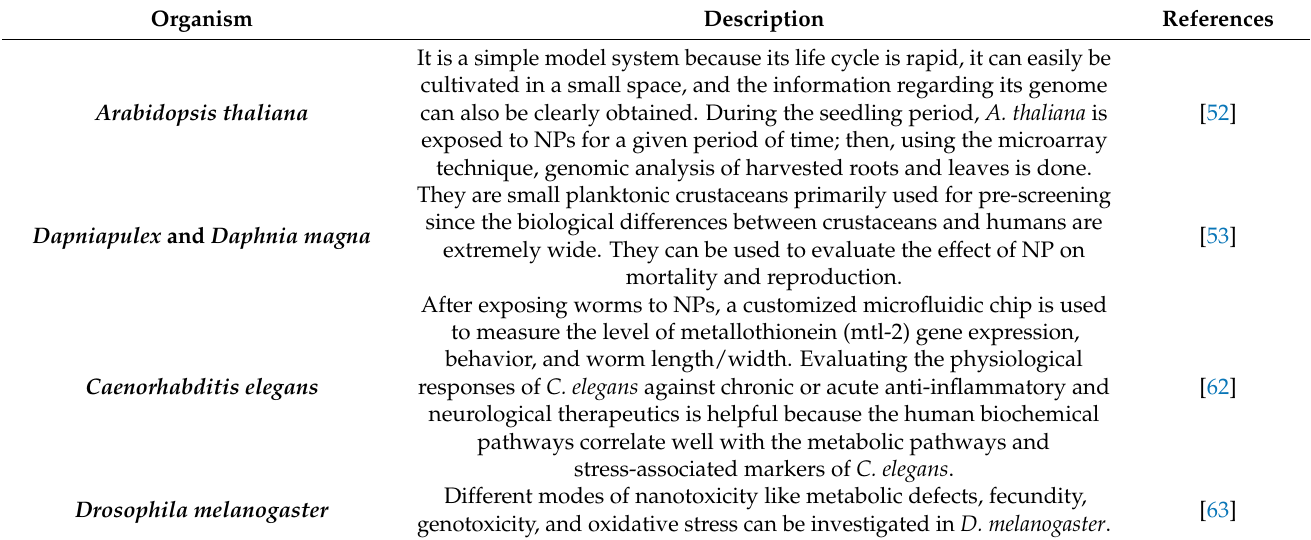
Table 2. Organisms used for the evaluation of in vivo